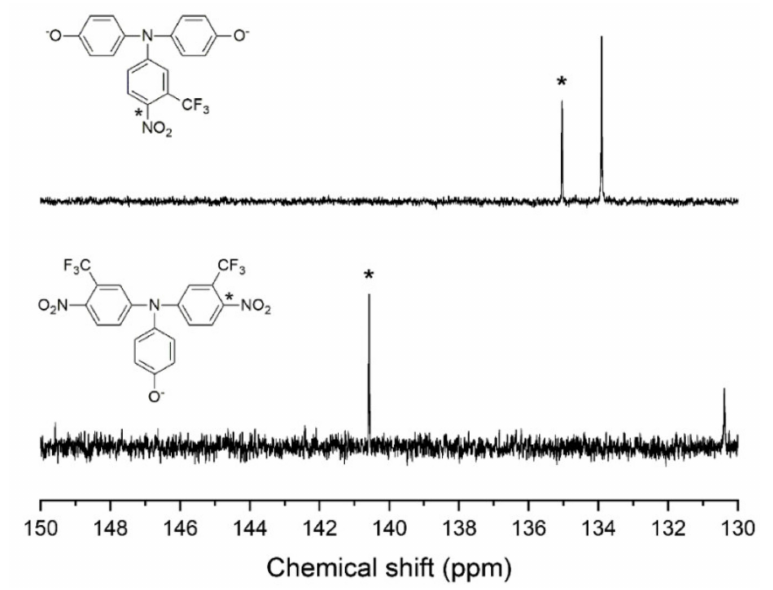
Figure 2. Chemical shift of 4-K (above) and 5-K (below) (DMSO- d 6, 150